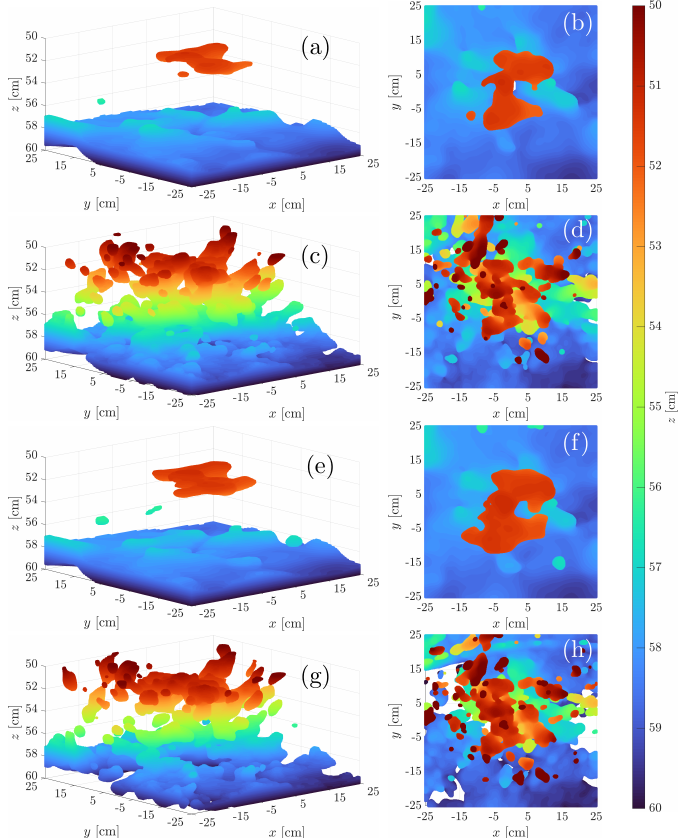
Figure 9. A comparison of the results of Ellis and Crowe [28] ( a , b ), Lambert [21] ( c , d ), Phong [27] ( e , f ), and no scattering model ( g , h ). Tuned Ellis and Crowe model and Phong model give the best-resolved